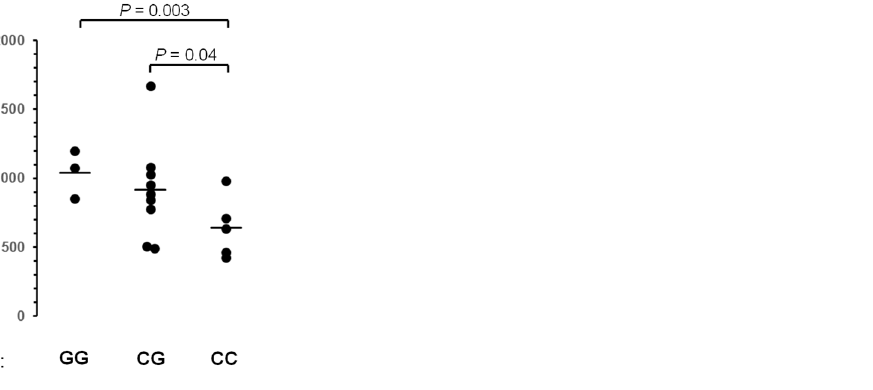
Figure 2. Expression of SCNN1B in rectal suction biopsies from F508del- CFTR homozygous CF patients. Data was retrieved for probe set 205464_at, representing SCNN1B , from global transcriptome analysis [35].